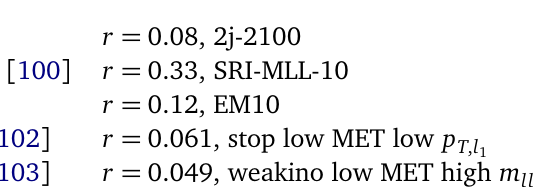
∈ [ 300,350 ] GeV. Finally, T